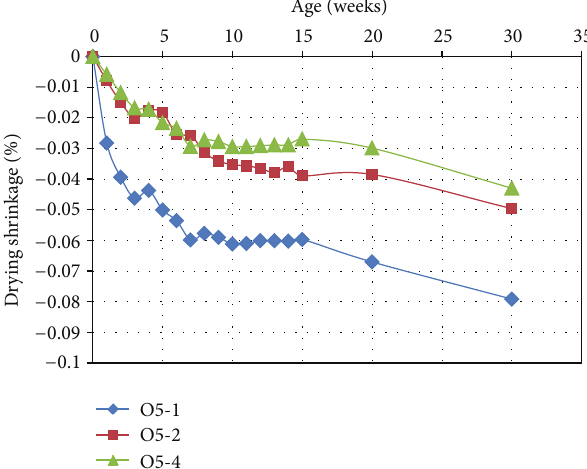
Figure 4: Compressive strength of geopolymer mortar heat cured for 2 hours.